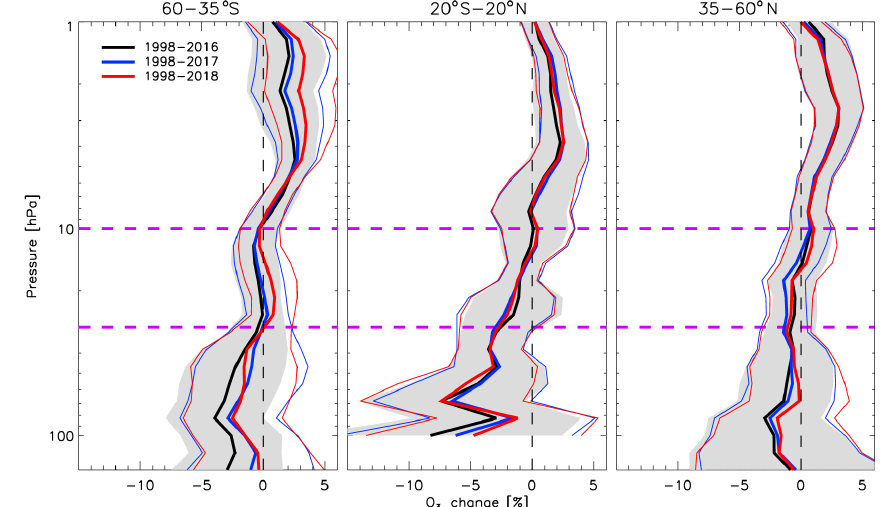
Figure 8. The ozone profiles for 1998 to an end year of 2016 through 2018 (see legend) in the Southern Hemisphere (60–35 ◦ S), the tropics (20 ◦ S–20 ◦ N), and the Northern Hemisphere (35–60 ◦ N). Shading is for 2016 only. Uncertainties are 95% credible intervals. Pink lines indicate the boundaries of partial columns in other figures.